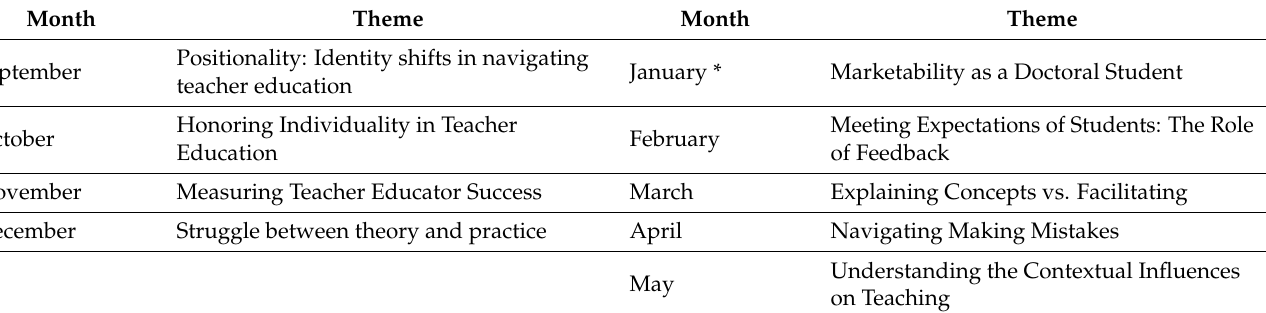
Table 1. Themes generated in first coder